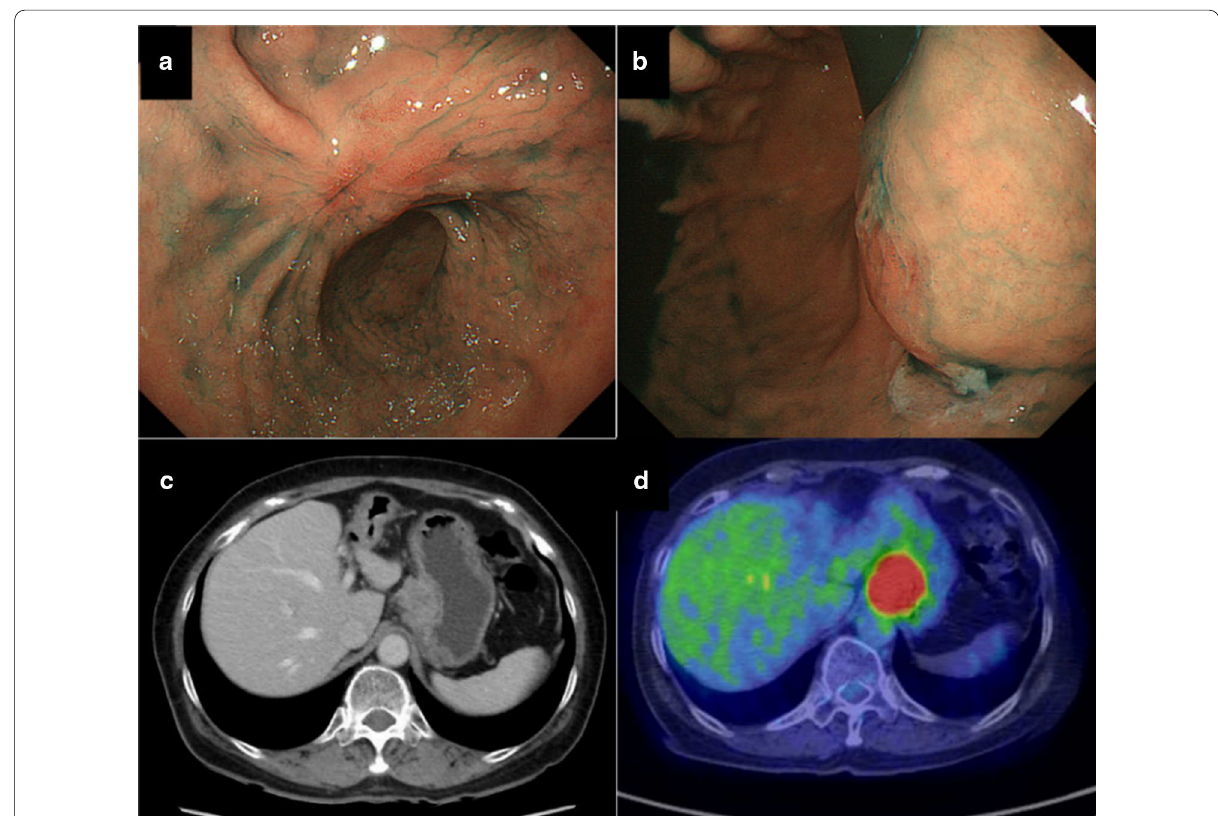
Fig. 1 Preoperative findings. a , b EGD found ESD scar at the lesser curvature of antrum and a SMT at the lesser curvature of cardia. c CT shows an approximately 30-mm, high density, round mass at the lesser curvature of upper gastric body. d Uptake of fluorodeoxyglucose seen on